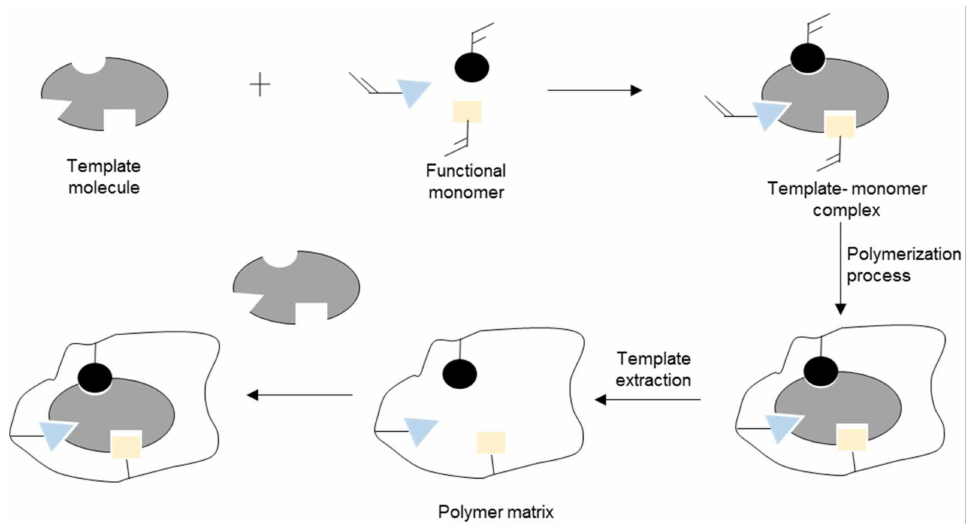
Figure 2. General Scheme for in situ polymerization